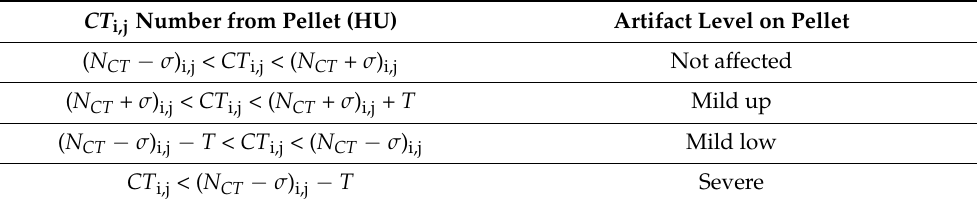
Table 2. Criteria for pellets classification in relation to the level of